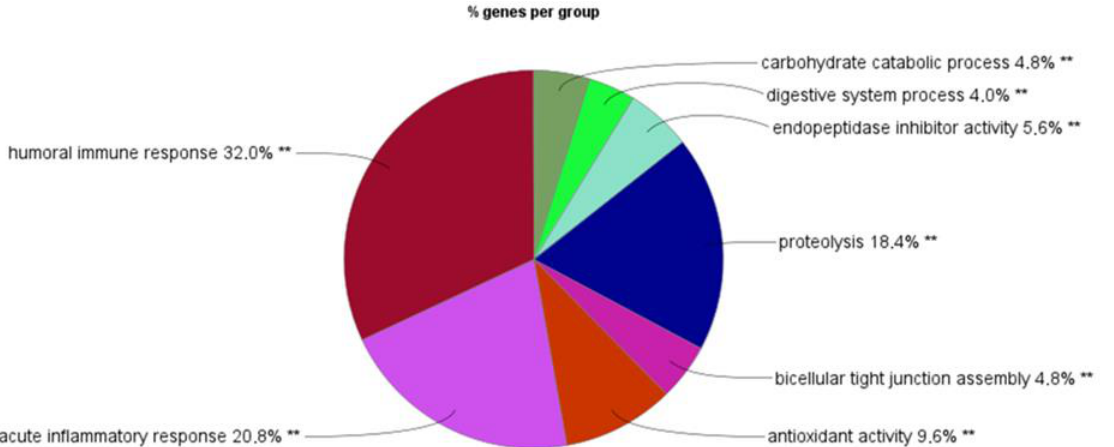
Figure 3. ROC scatterplot summarizing differentially abundant proteins in NEC stools. “Volcano - type ” ROC scatter-plot of 489 proteins with ≥ 38 quantified values. On the plot, the x-axis represents the log2 fold change ratio of the mean protein levels of NEC vs. non-NEC control samples, the y- axis is the area under the curve (AUC) of the receiver operating characteristic (ROC) curve and the orange and green dots show down- and up-regulated protein levels passing the 0.7 AUC threshold (dashed line), respectively. For more clarity, gene symbols are used on the plot (see Supplementary Table S1 for corresponding protein name). Some labels have been skipped.